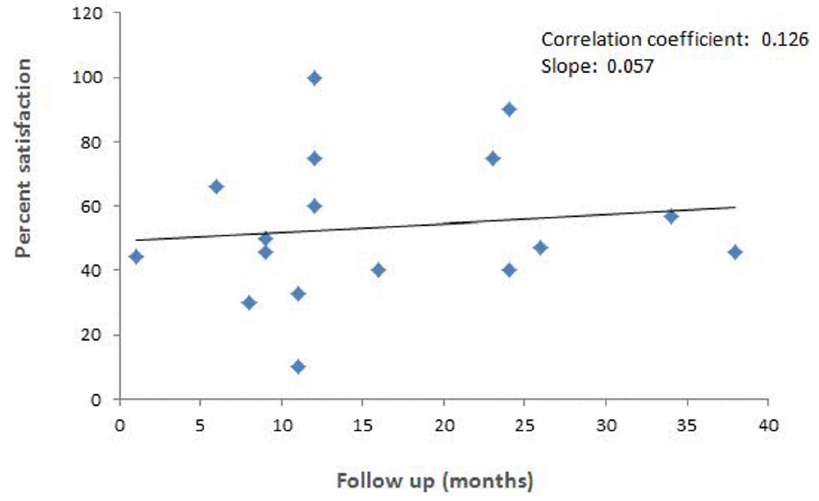
Figure 5. Scatter plot showing relationship between percent satisfaction of the subjects of percutaneous resolution procedures and follow-up duration in